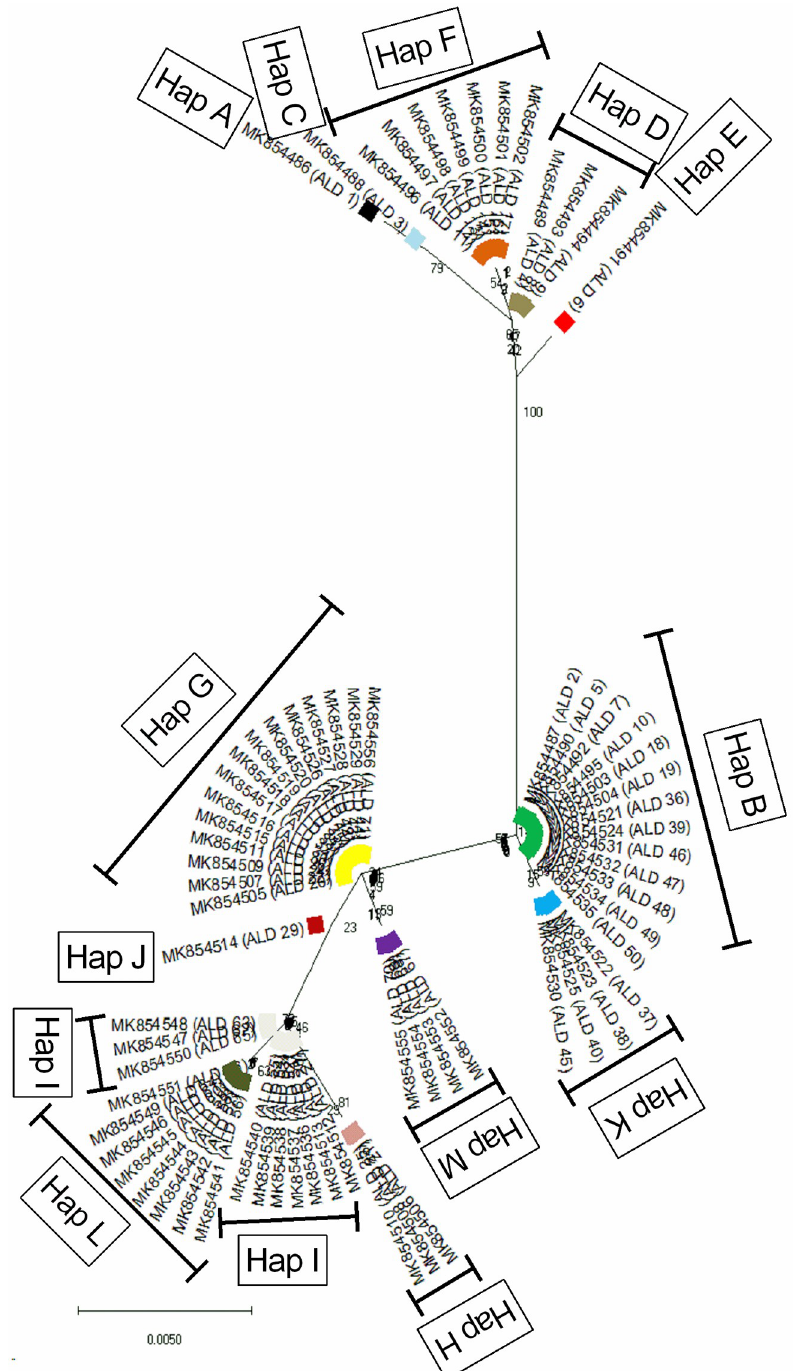
Fig 1. Evolutionary relationship of the 13 detected haplotypes of Andaman local duck (ALD). The evolutionary relationship was established using the Neighbor-Joining method using Tamura-Nei model as implemented in MEGAX following 1,000 bootstrap